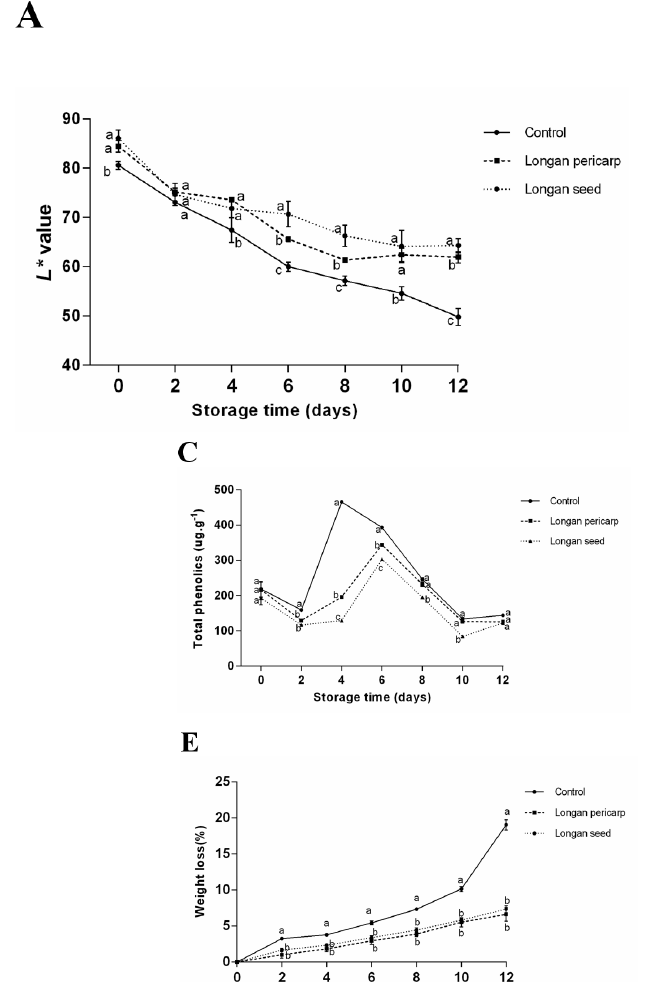
8 of 16 Figure 4. Apparent changes in fresh − cut lotus roots treated with different solutions during storage for 12 days at 4 °C. 2.4.2. Browning Degree of Fresh − Cut Lotus Roots The browning degree of fresh − cut lotus roots was evaluated by detecting the changes in the surface color difference and absorbance values of a water solution [26]. The color difference values are shown in Figure 5A. It was found that the L* value decreased with increases in storage time. After being treated and left at room temperature for 2 h, the L* value of the experimental group was significantly higher than that of the control group ( p < 0.05), which indicated that the fresh − cut lotus roots showed an antibrowning effect after the DLP and DLS ECT treatments in a short time. On the 2nd day, the L* of all lotus roots significantly decreased due to the physical damage of the fresh − cut lotus roots, which led to the release of ECT content. Based on the literature, we inferred that the REDOX reaction rate increased two days before storage, and a large amount of melanin was produced [27]. On the 4th day, the L* value of the control group continued to decrease, but the treatment group maintained a strong state, especially the DLS treatment group, whose L* value showed little difference from that of the 2nd day. After the 6th day, there were significant differences between the three groups. The effect of the DLS treatment group was signifi- cantly better than that of the DLP treatment group, and the effect of the DLP treatment group was better than that of the control group ( p < 0.05). As a lotus root slice has several holes, some small areas could not be detected with a chromometer. As a supplement, the absorption value of the fresh − cut lotus roots at 420 nm was detected with the extinction coefficient method. The extinction coefficient method can be used to directly detect the soluble pigment compounds produced in the storage process of fresh − cut lotus roots. The detection results are shown in Figure 5B. Consistent with the L* results, the browning degree of the control group was significantly higher than that of the experimental group ( p < 0.05). In the course of storage, this gap was gradually amplified, while the fresh − cut lotus roots treated with longan pericarp and longan seed ECTs maintained their initial state. The browning degree of the experimental group began to increase from the 2nd day, and this rate gradually increased. In contrast, the browning degree of the fresh − cut lotus roots in the experimental group showed almost no change in the first 4 days, remaining at a low level of about 0.045. From the 6th day, the browning degree of the longan pericarp ECTs treatment group slightly increased to 0.167 while that